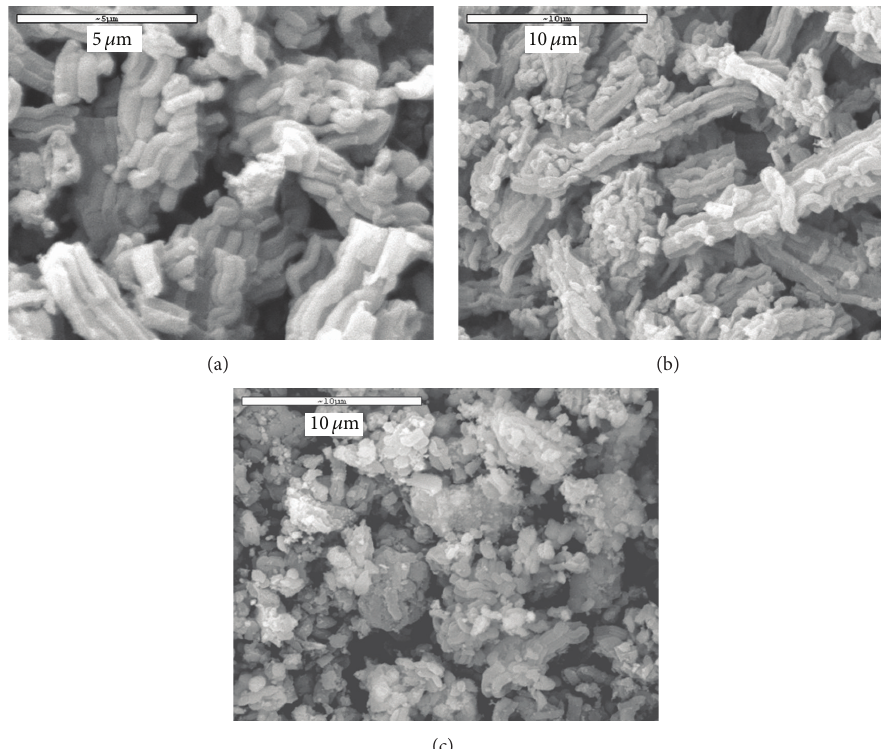
Figure 3: SEM images of the pure SBA-15 (a), TiO 2 -SBA-15 (b), and N-TiO 2 -SBA-15 (c).